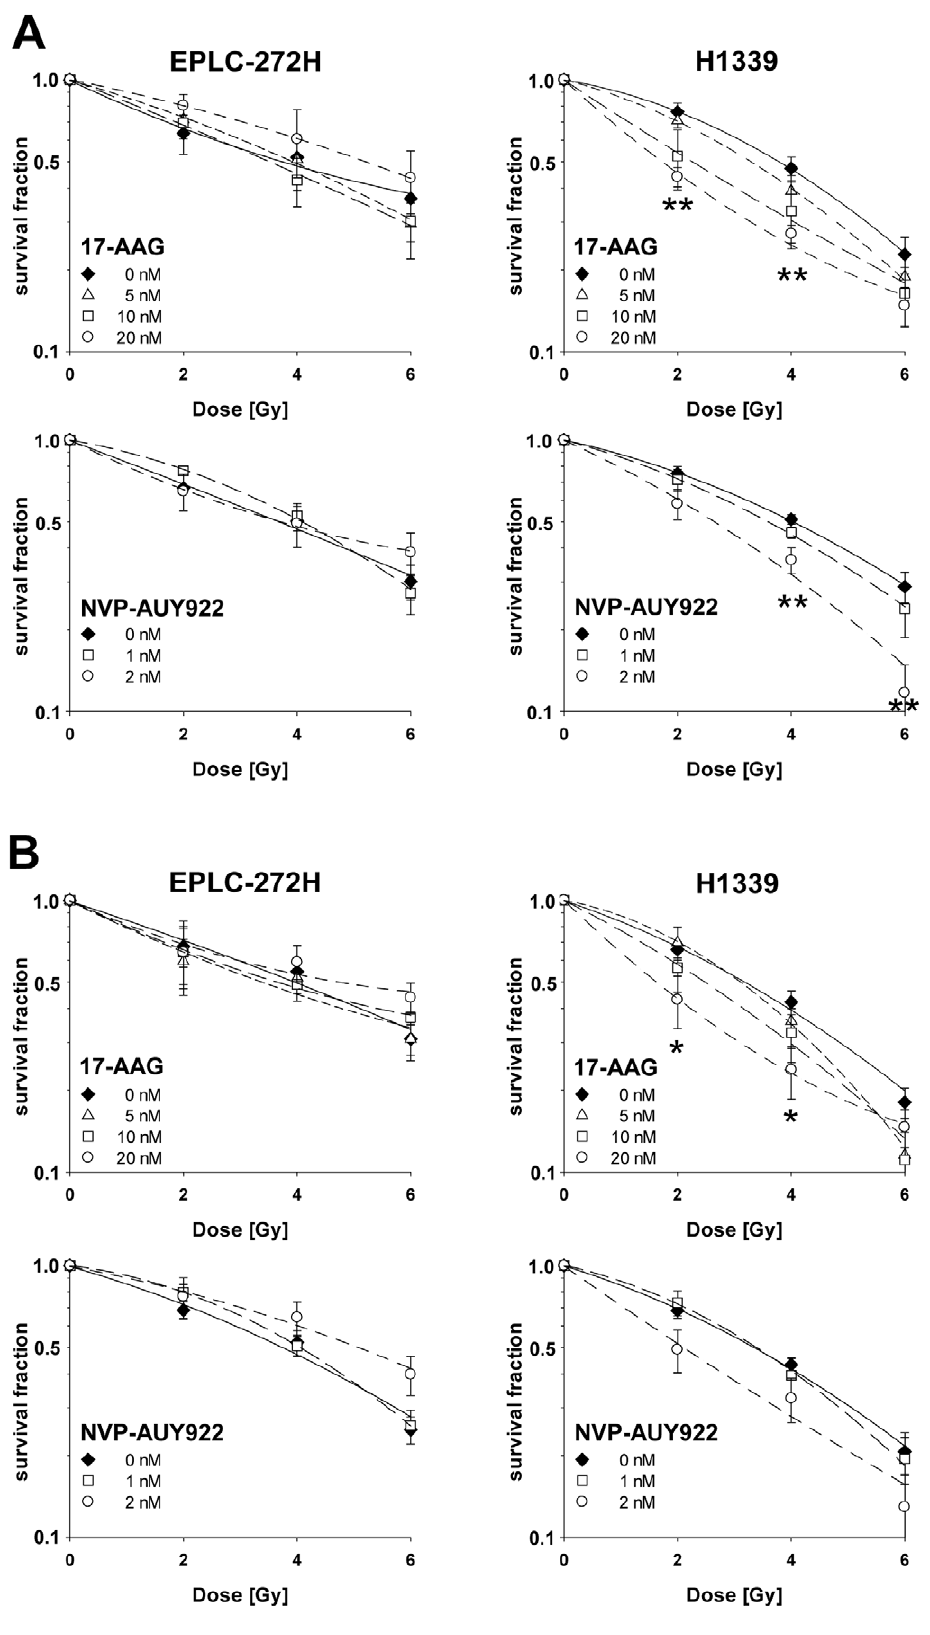
Figure 5. Hsp90 inhibitors increase radiosensitivity of H1339 lung cancer cells under normoxic and hypoxic conditions. EPLC-272H and H1339 cells were treated with 17-AAG (5, 10, 20 nM) or NVP-AUY922 (1, 2 nM)) or vehicle control (0 nM), 30 min later exposed to normoxic (A) or hypoxic (B) conditions for 24 h and, after 5 min of reoxygenation, irradiated with increasing doses of x-rays. Drugs were present until fixation of PLoS ONE |